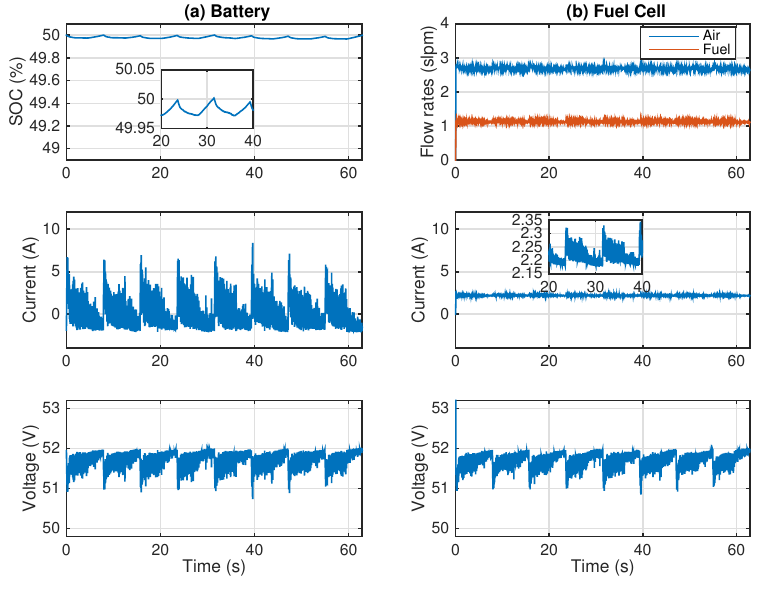
Figure 13. High-SOC passive hybrid simulation. ( a ) Battery response, ( b ) FC response. Simulations for medium and low SOC conditions are shown in Figures 14 and 15, respectively. Very similar profiles to the ones seen in Figure 13 can be observed: the battery and FC work together to handle the load currents with almost constant FC current and the presence of peaks of current in the Battery. Once more, the Battery SOC ends at the same value it starts. The profiles seen in Figures 14 and 15 show again almost constant values for the variables of the FC. However, the small differences are detailed below.